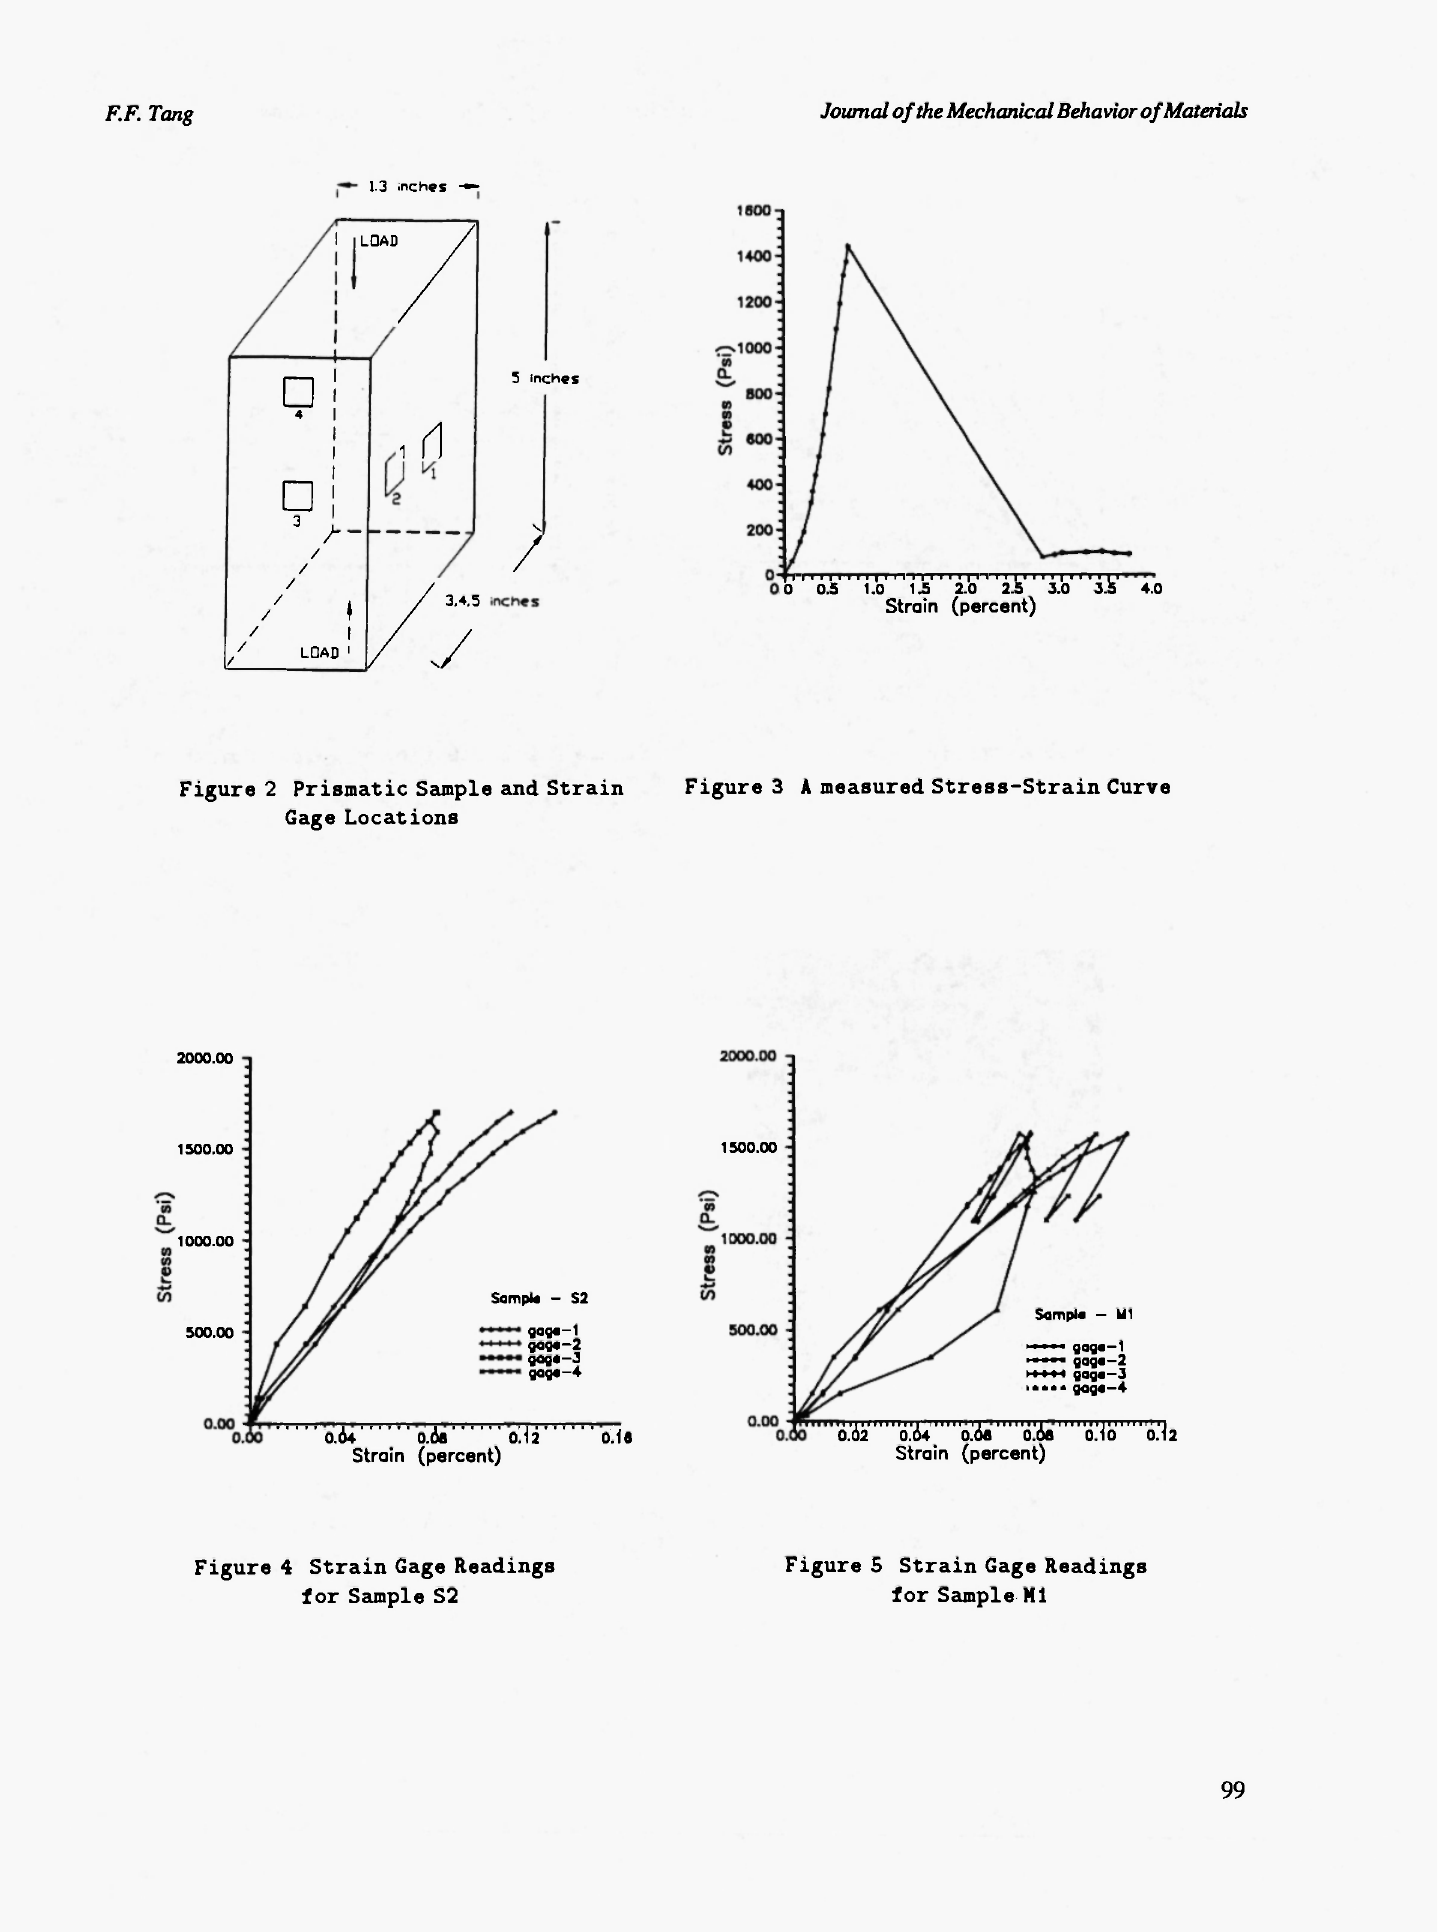
Figure 5 Strain Gage Readings for Sample